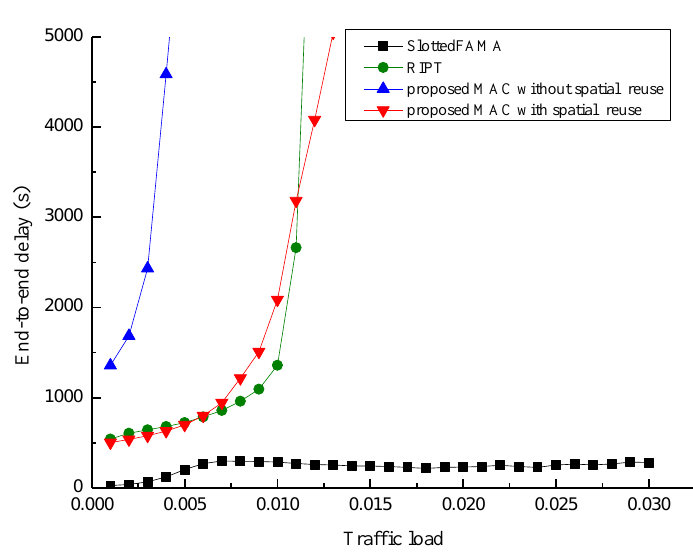
Figure 12. End-to-end